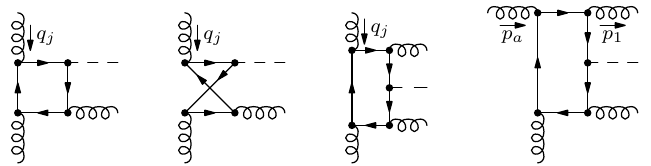
Figure 5 . Examples for additional gluon emission o(cid:11) the heavy quark loop. These emissions are suppressed for large rapidity separations. Here vertical lines represent o(cid:11)-shell t -channel propagators and horizontal lines represent on-shell external